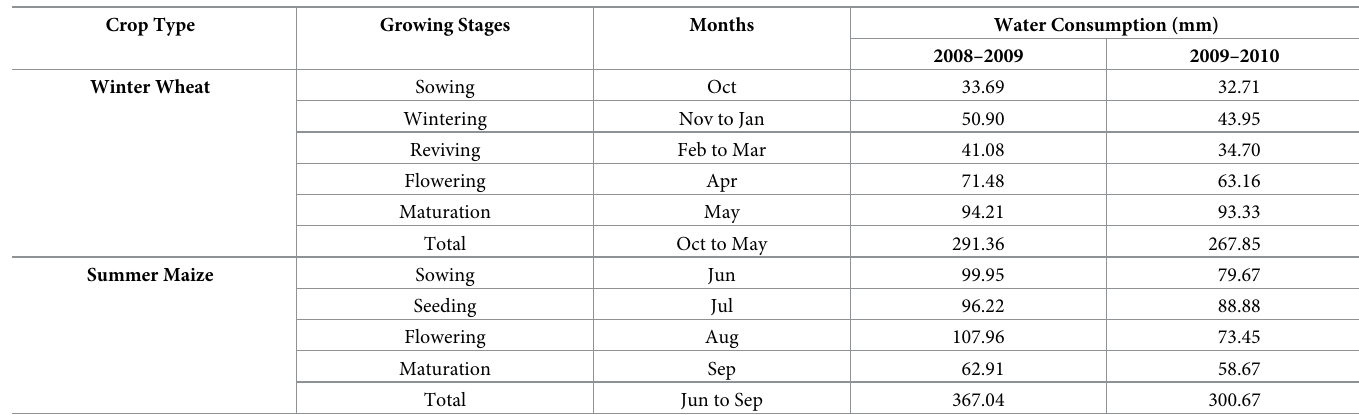
Table 3. The general performance results of simulated daily evapotranspiration. Crop